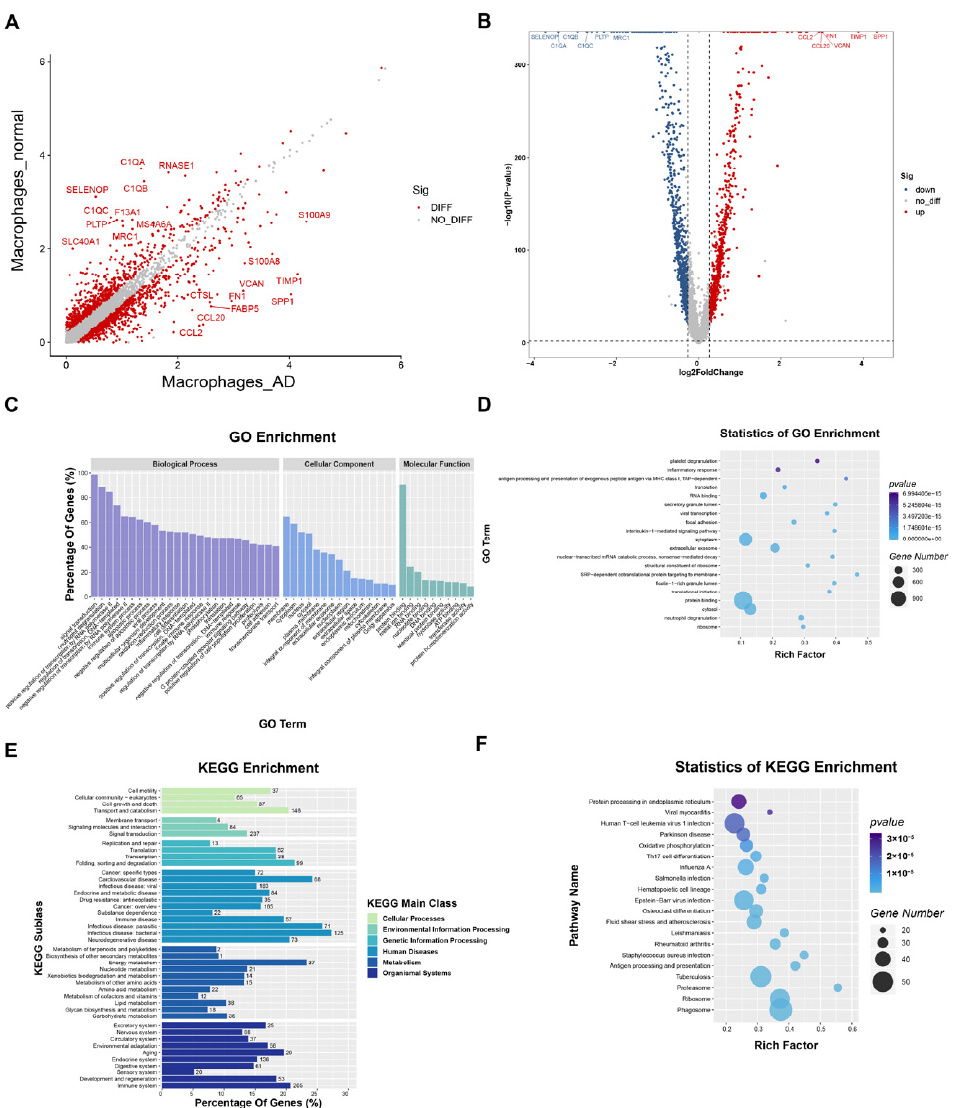
Figure 3. Distribution characteristics of differential genes in macrophages from the AD and normal groups. ( A ) Scatter plot of differential genes in macrophages between the AD group and the normal group. ( B ) Volcano plot of differential genes in macrophages for the AD group vs. the normal group. ( C ) GO enrichment analysis of DEGs. ( D ) Statistical bubble plot of GO enrichment analysis entries. The abscissa is the degree of enrichment, the ordinate is the GO entry, the size of the bubble represents the number of genes, and the color represents the p -value. ( E ) KEGG enrichment analysis of DEGs. ( F ) Statistical bubble plot of the KEGG enrichment analysis entries. The abscissa is the degree of enrichment, the ordinate is the KEGG entry, the size of the bubble represents the number of genes, and the color represents the p